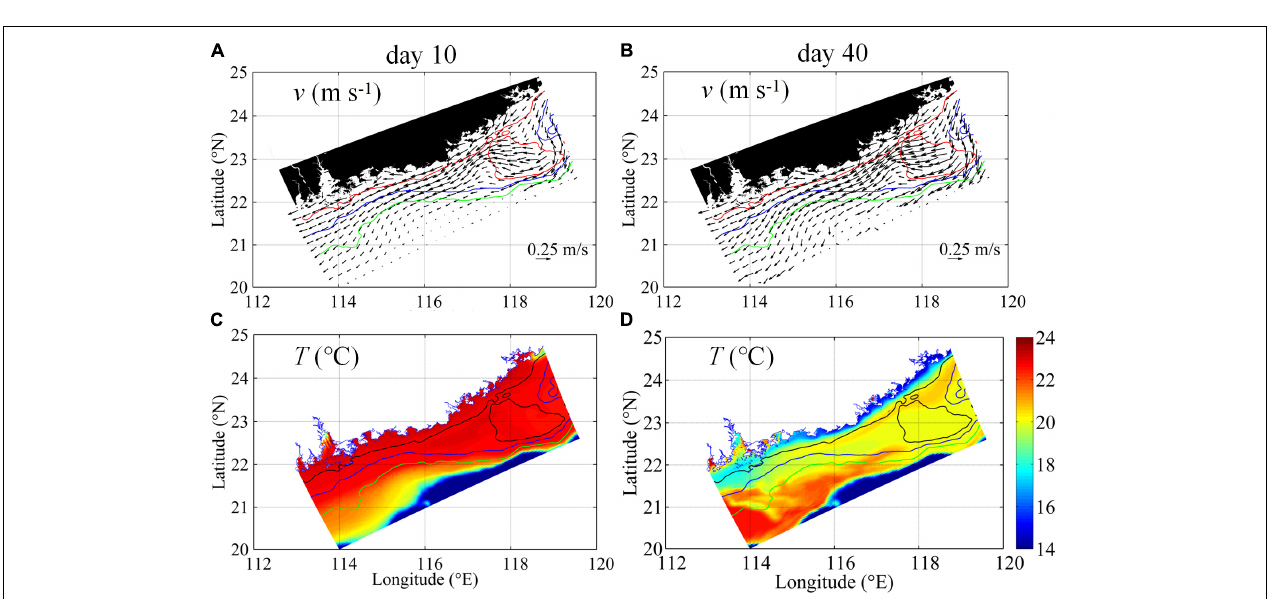
FIGURE 6 | Bottom velocity vectors (m s − 1 ) (A,B) and temperature ( ◦ C) (C,D) on Day 10 (left) and on Day 40 (right). The red, blue, and green lines mark the 30, 50, and 80 m isobaths (A,B) , and the black, blue, and green lines indicate the 30, 50, and 80 m isobaths (C,D) , respectively.